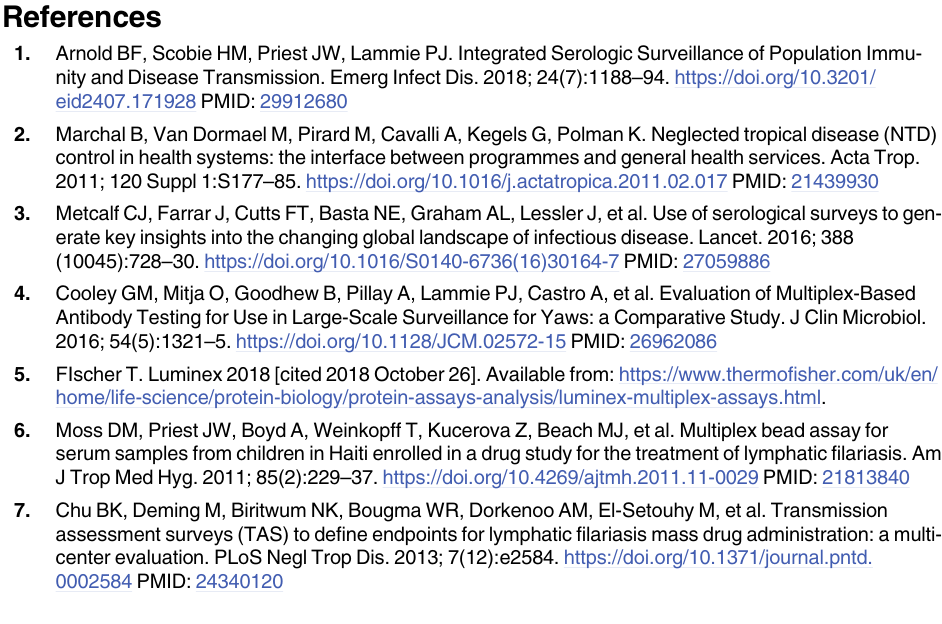
S1 Table. List of Articles